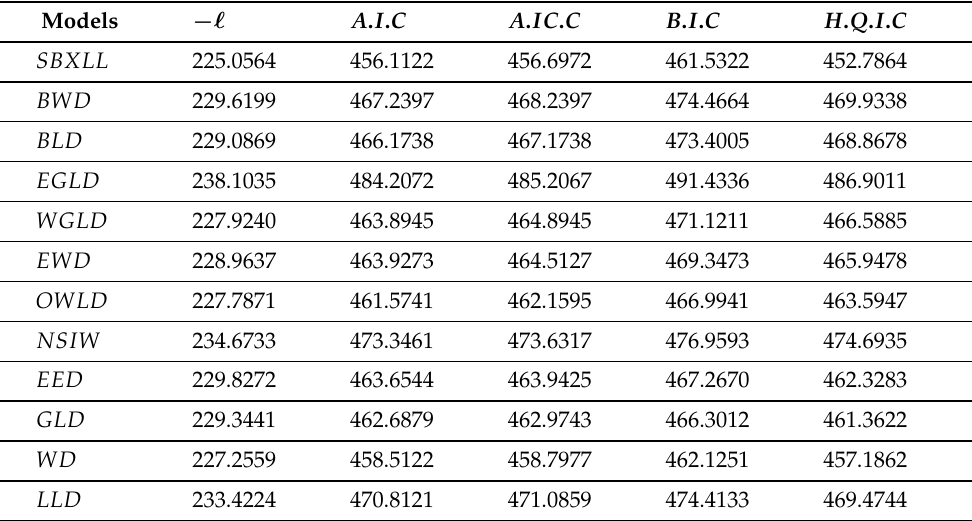
Table 23. Comparison of data set IV fitting via information